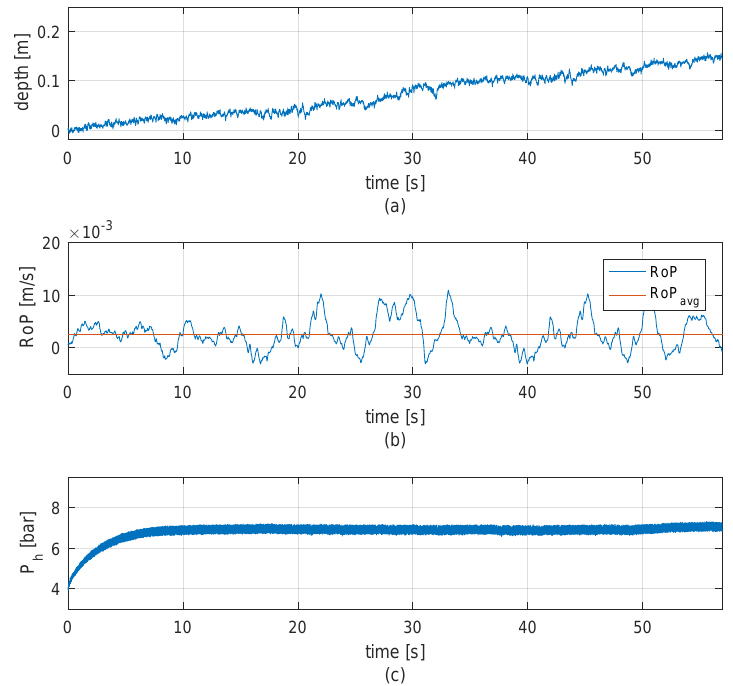
Figure 10. Evaluation of observer-based MWD system during drilling condition of QR-R4, measured variables: ( a ) depth; ( b ) RoP and average RoP; ( c ) P h .